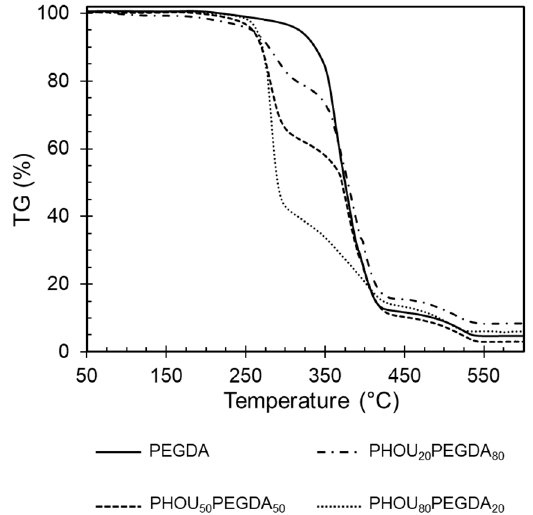
Figure 4. DSC thermograms of PHOUxPEGDA 1 − x ( A ) and variation of T g in function of PEGDA content ( B ).